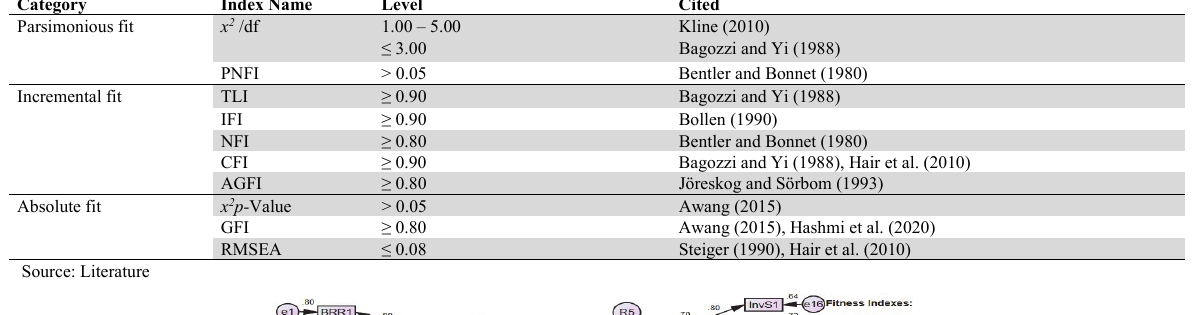
Goodness of fit indices for measurement model Category